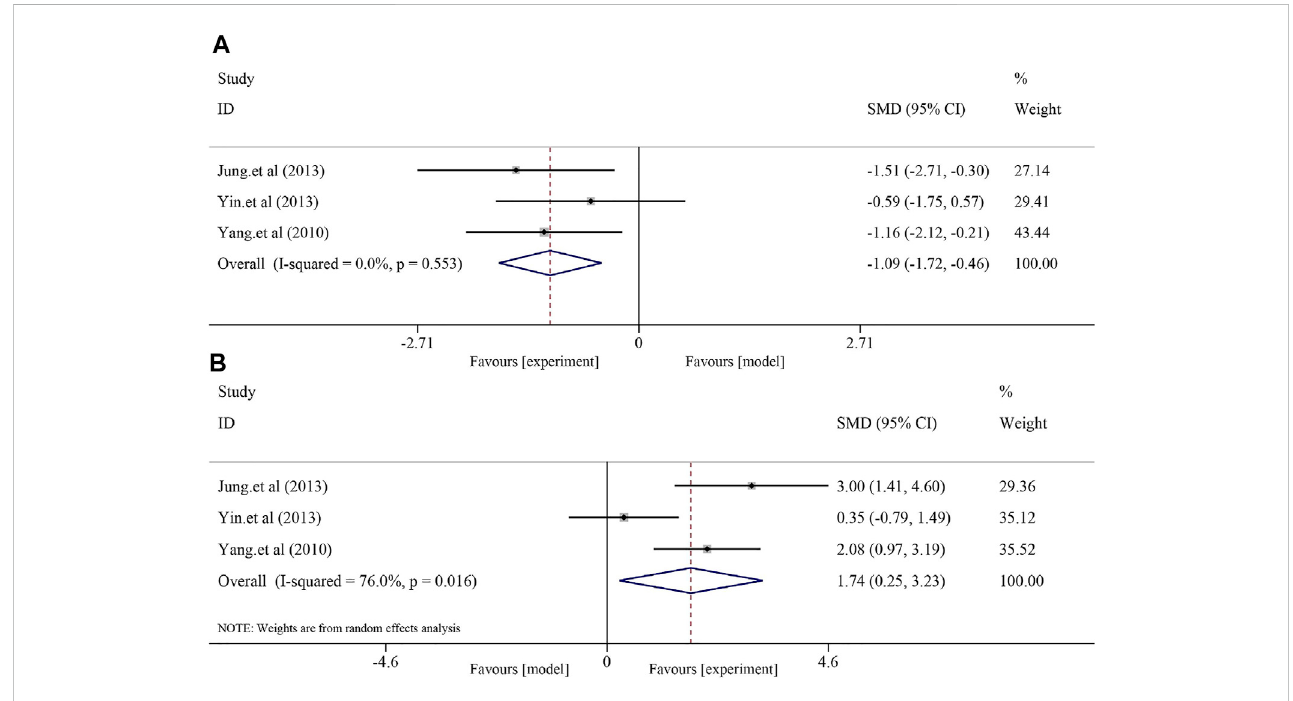
FIGURE 4 Effect of soybean on MDA and SOD levels in preclinical studies. (A) Pooled effect of MDA. (B) Pooled effect of SOD.